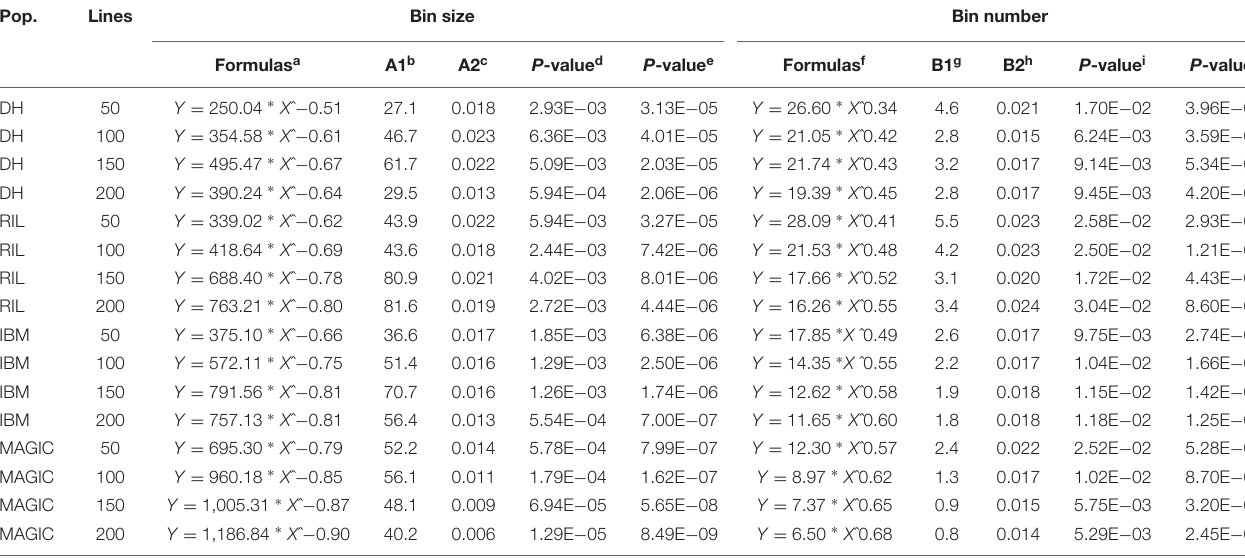
TABLE 4 | Formulas for recombination bin number and size for different sets of lines in four types of population Pop.